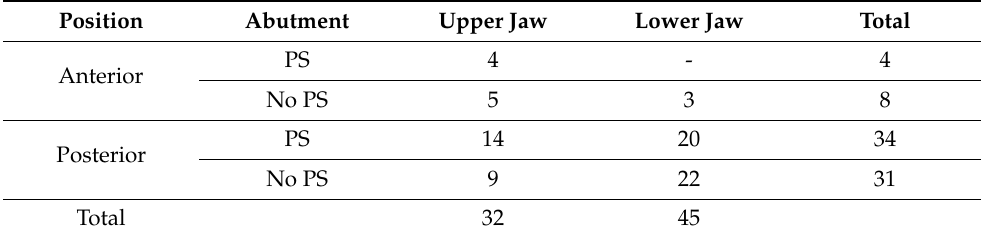
Table 1. Implant distribution considering implant site and features.